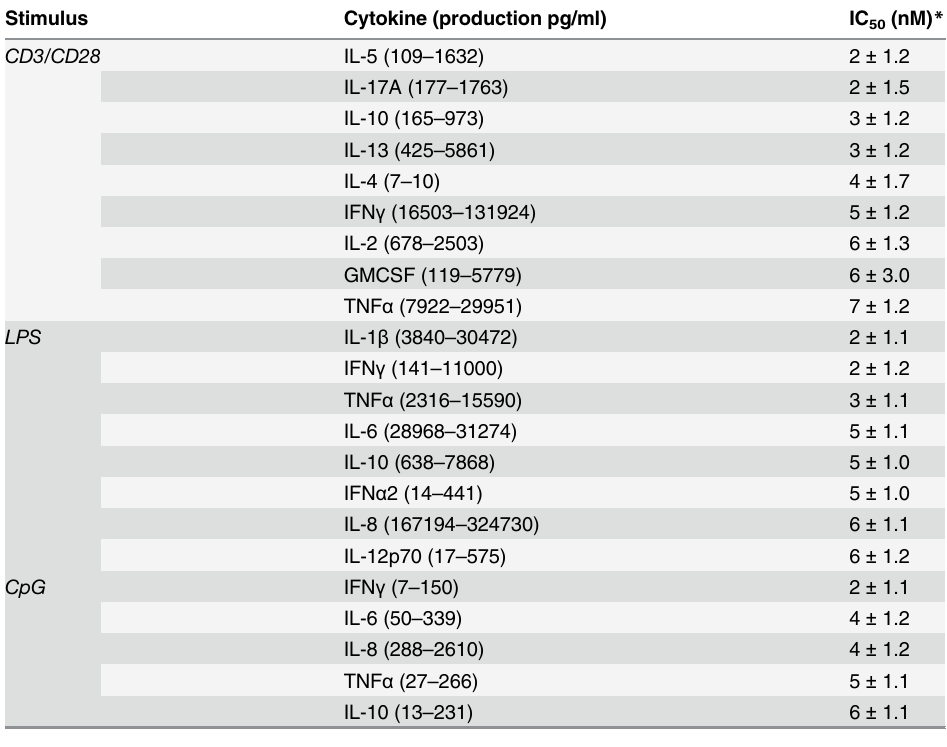
Table 1. HSP90 inhibition by ganetespib blocks in vitro PBMC cytokine production induced by multi- ple